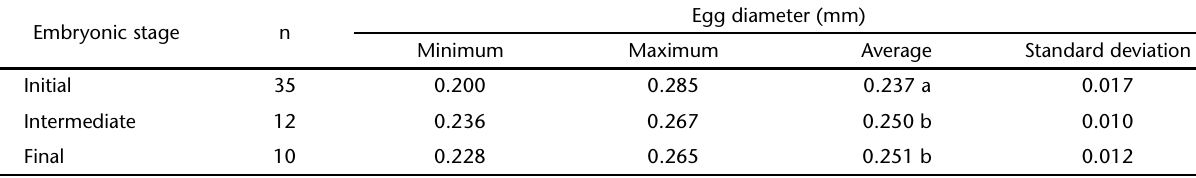
Table III. Variation of egg diameter for each embryo stage of U. rapax from Itaipu Lagoon. Equal letters show no statistical difference (p>0.05). Embryonic